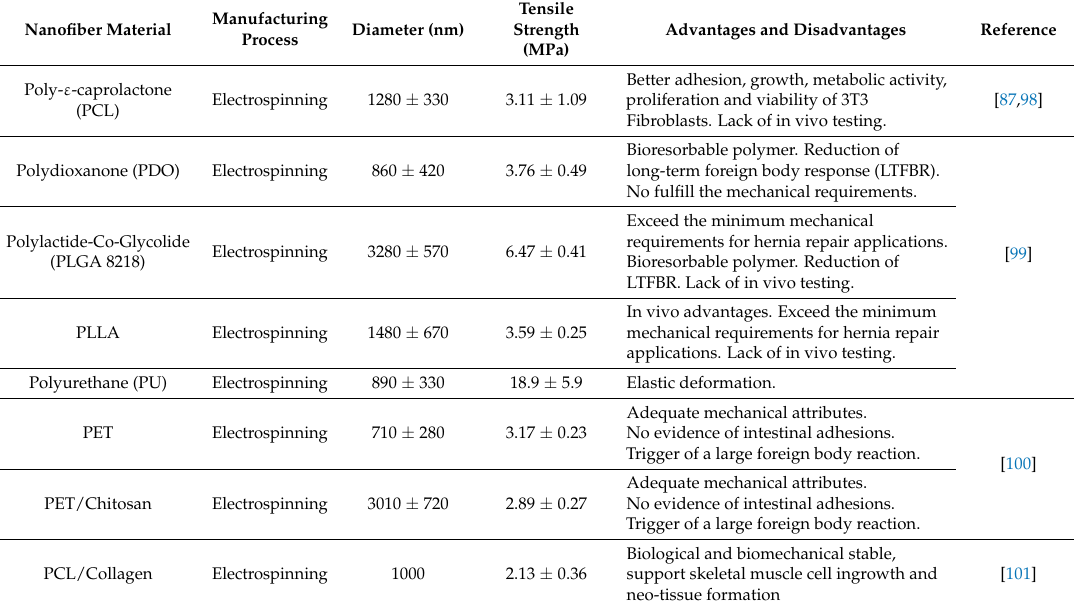
Table 7. Nanofiber based surgical